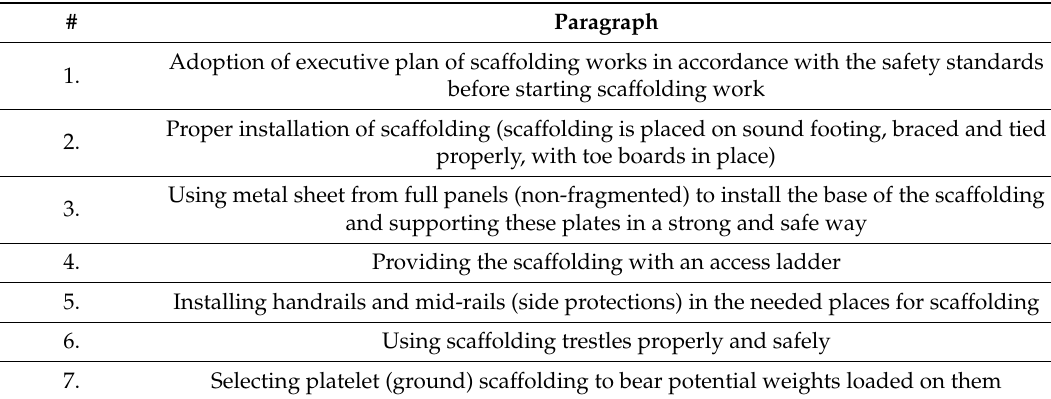
Table 3. Paragraphs used for F1 (appropriate scaffolding work for